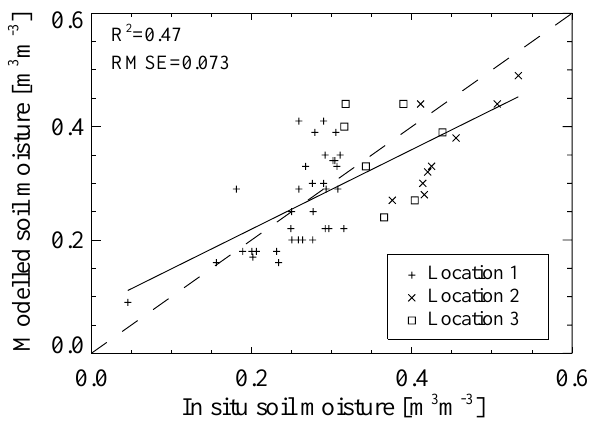
Fig. 3. Validation of modelled soil moisture over 10cm depth at three in situ measurement locations (see corresponding annotations in Fig.